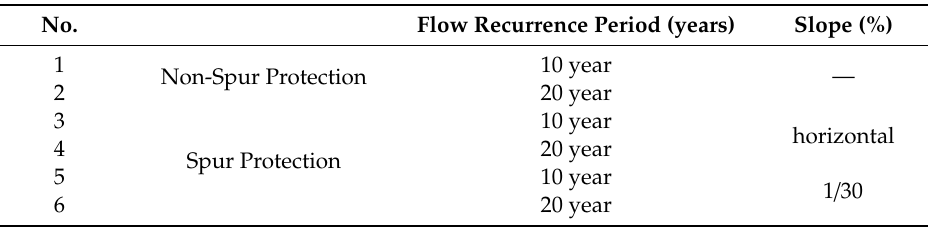
Table 1. Setups of Table 1. Setups of experiment.